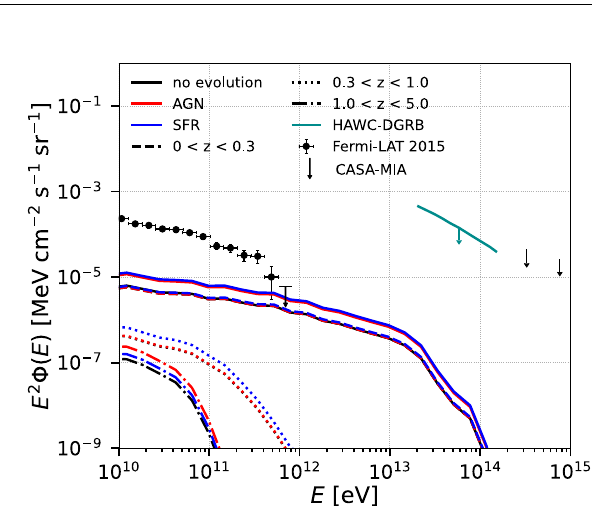
Fig.2|Gamma-ray fl uxfromclustersatdifferentredshiftintervals. Total fl uxof gammaraysfor α =2.3and E max =10 17 eVovertheentireredshiftrange(solidlines) andalsofordifferentredshiftintervals(dash-dotted,dotted,anddashed).Thesolid lines are the sum of dashed, dotted and dashed-dotted lines. The fi gure also comparesthe fl uxincludingtheseparatedcontributionsoftheevolutionoftheCR sources (AGN and SFR) with the fl ux when there is no source evolution. For com- parison, the observed fl ux by Fermi-LAT is depicted (error bars correspond to the totaluncertainties,statisticalandsystematic) 66 ,aswellastheupperlimitsobtained by HAWC (95% con fi dence level) 31 and CASA-MIA (90% con fi dence level) 32